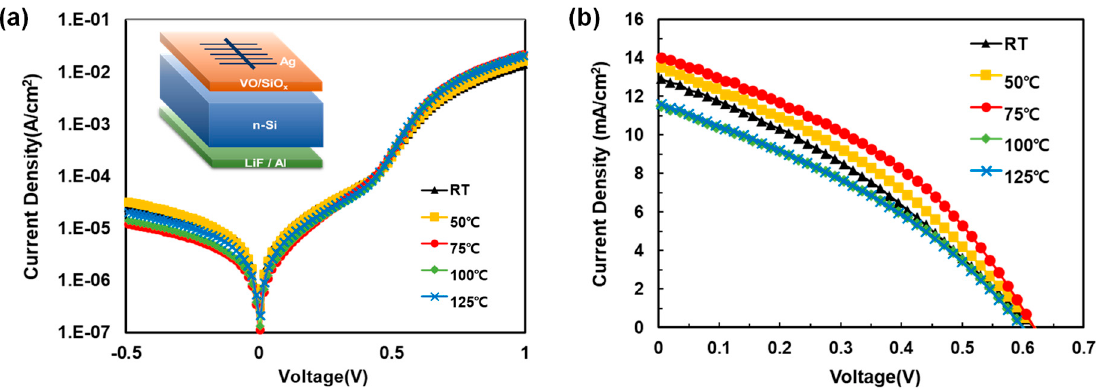
Figure 10. Current density vs. voltage curves of Si/V 2 O 5 − x HSCs measured under ( a ) dark and ( b ) 100 mW/cm 2 illumination (AM1.5) conditions.